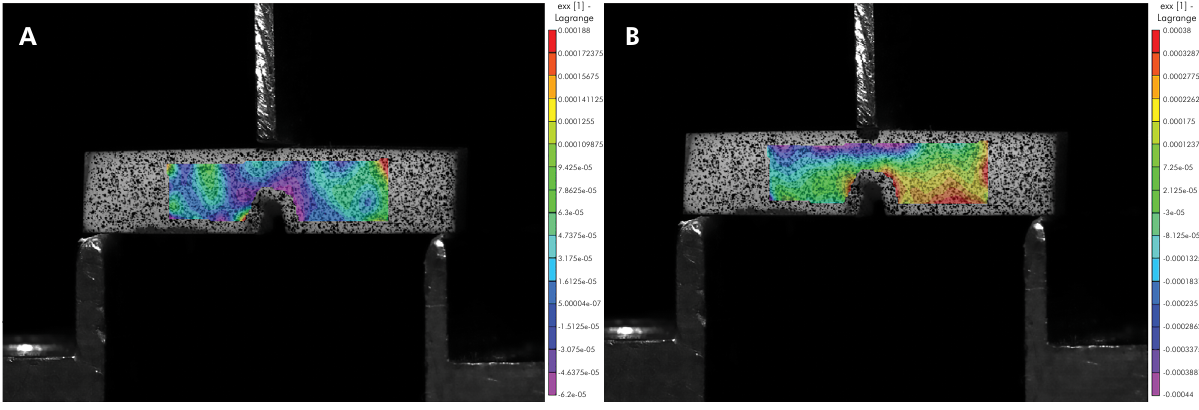
Figure 4. (a) Leucite-reinforced glass ceramic shows the initial compression area spread on the surface of the specimen. (b) As presented by the feldspathic ceramic in fig. 3(a) at the top of the V-notch the tensile is characterized by the loading concentration in sharp corners. The same pattern can be observed in this figure for leucite-reinforced glass ceramic.